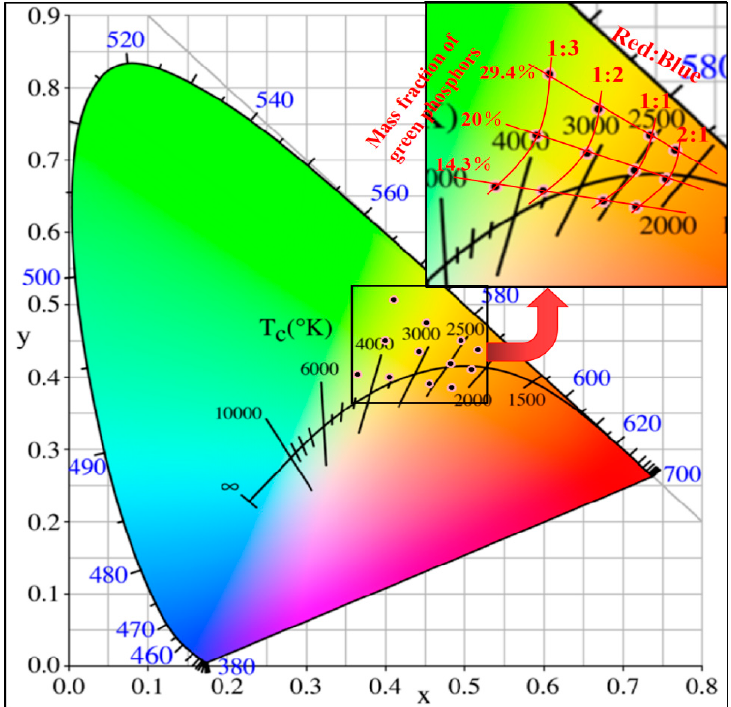
Figure 4. CIE values obtained for designed CSP LED filament samples.